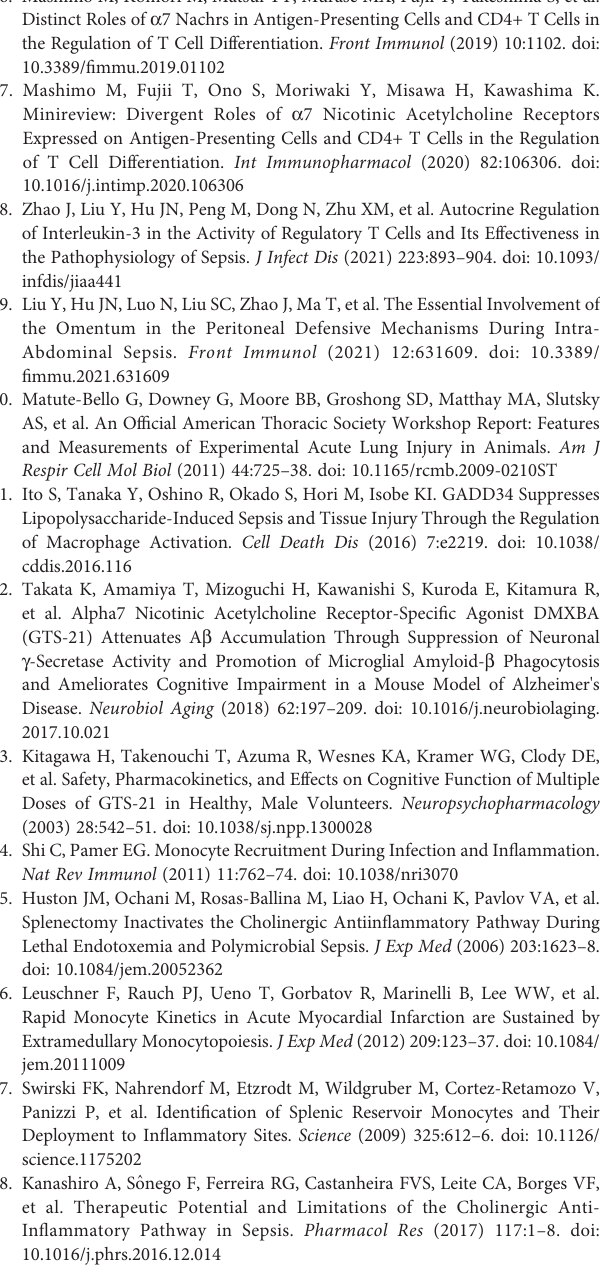
Supplementary Figure 1 | Representative dot plot showing the SSC x FSC gate of the sample from GTS-21 and vehicle treated mice in the cytometry analyzes. Supplementary Figure 2 | Representative histogram of Ly6C- and Ly6C+ of the sample from GTS-21 and vehicle treated mice in the cytometry analyzes. Supplementary Figure 3 | Representative dot plot showing the SSC x FSC gate of the sample from splenectomized mice treated with GTS-21 and vehicle in the cytometry analyzes. Supplementary Figure 4 | Representative histogram of Ly6C- and Ly6C+ of the sample from GTS-21 and vehicle treated splenectomized